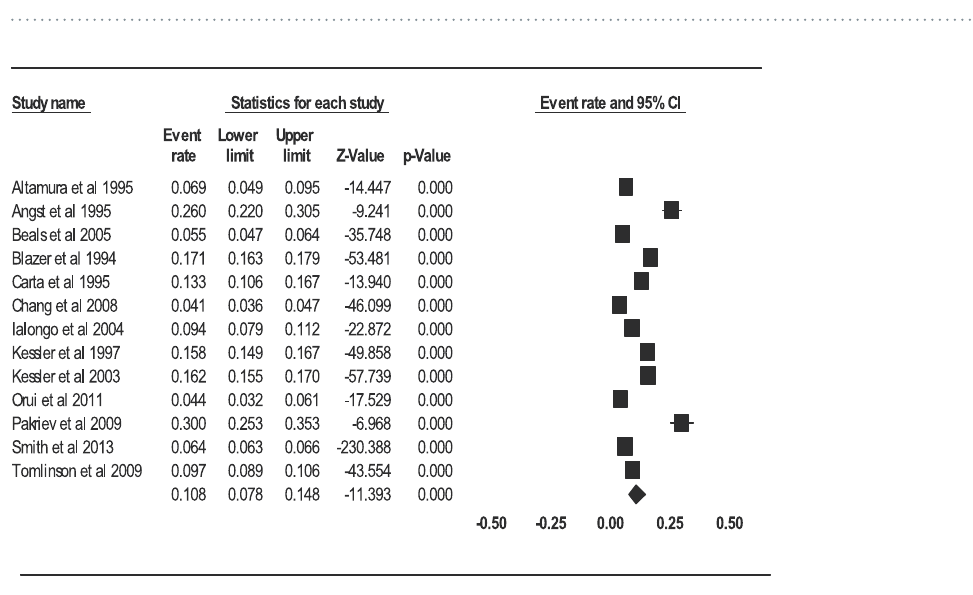
Figure 3. Forest plot of one-year prevalence of depression.